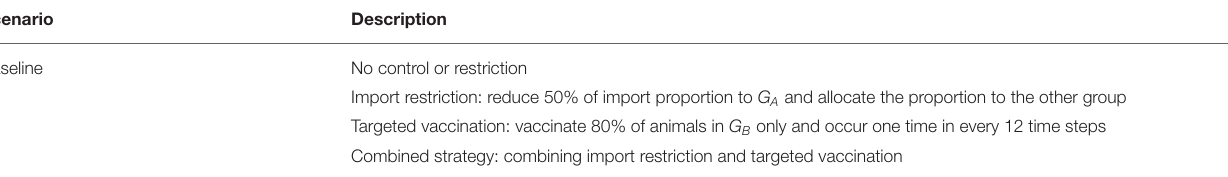
TABLE 3 | Scenarios description.